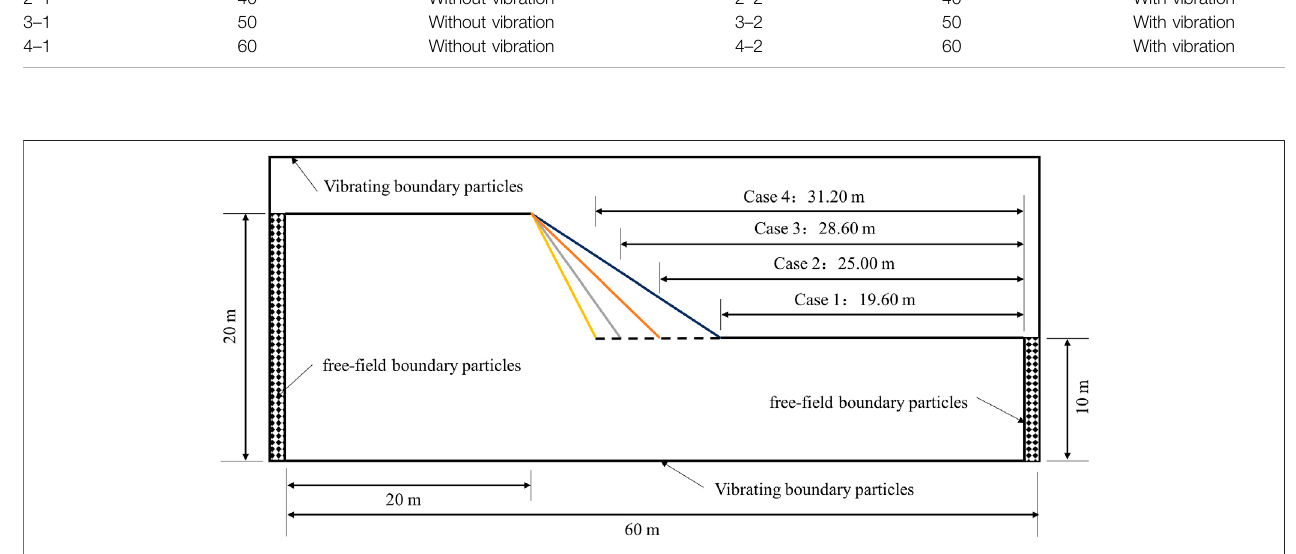
FIGURE 5 | Size chart of different slopes.